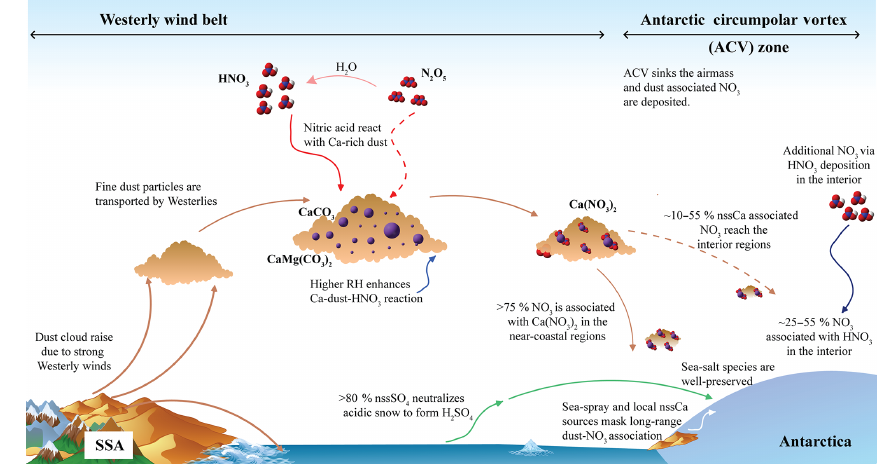
Figure 6. Schematic diagram depicting possible processes and chemical reactions involved during the mineral dust transport from southern South America (SSA) before depositing over Antarctic ice sheet. The estimates of NO − from this